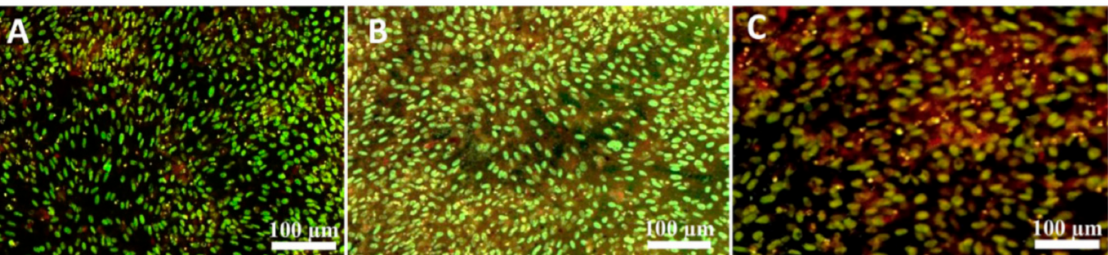
Figure 3. Saos-2 cell fluorescent images distribution on tissue culture plastic as a control ( A ); PCL-only scaffold ( B ); 1.0% weight MWCNT-PCL composite scaffold ( C ) [121].